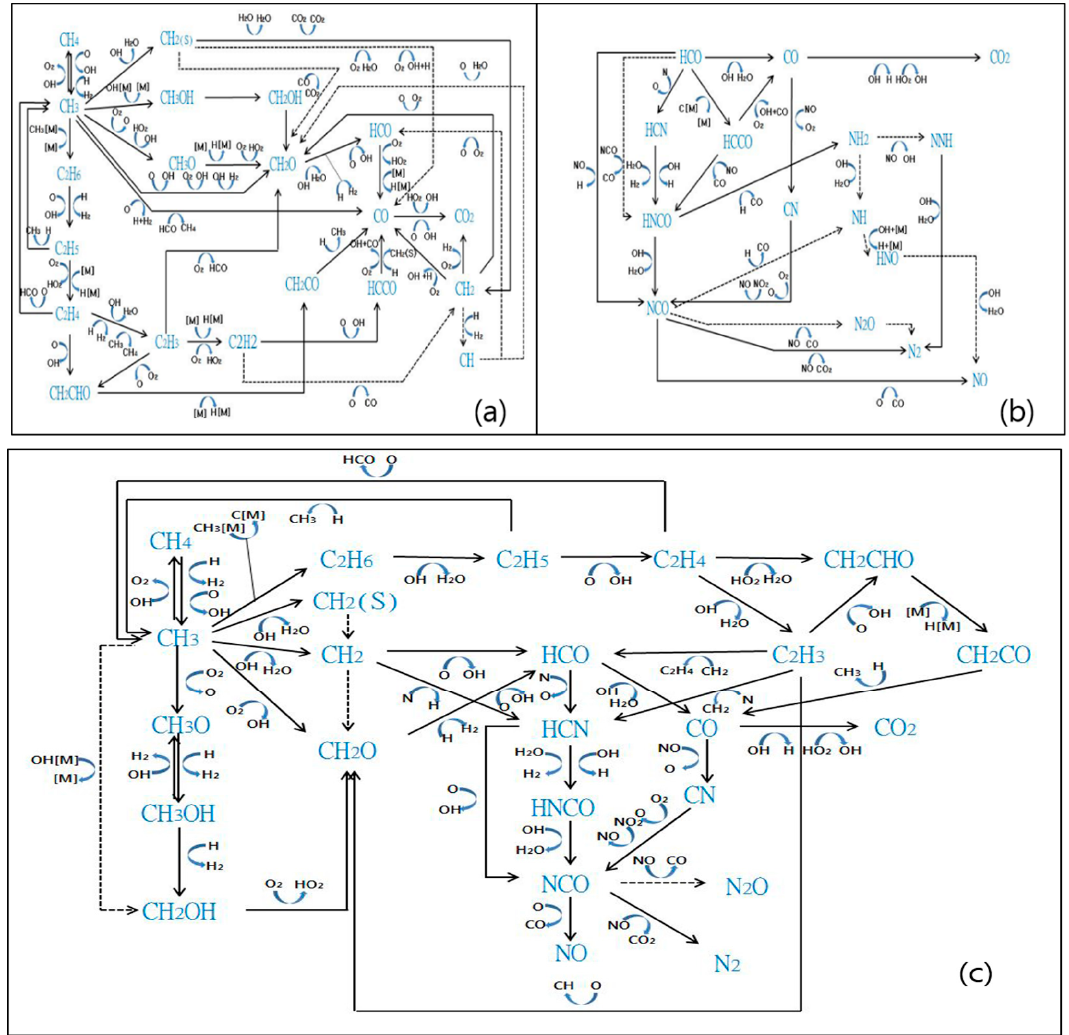
Figure 7. Reactions occurring during SNCR with CH4 as the reducing agent (NO = 900 ppm, NO 2 = 100 ppm, O 2 = 7 vol%, CH 4 NSR = 2, temperature = 900 °C). ( a ) CH4 oxidation reactions, ( b ) NOx reactions, ( c ) overall pathways.